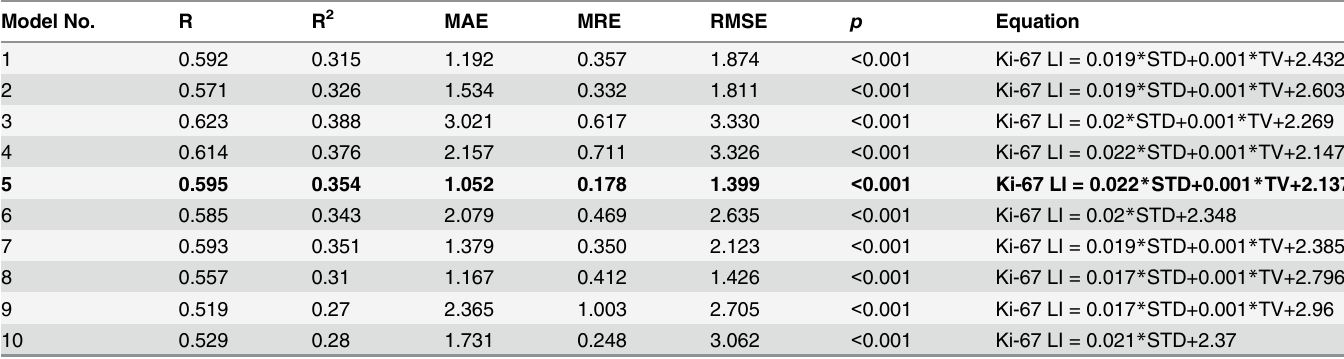
Table 3. 10-fold cross-validation of multi-linear regression model for Ki-67 by CT image parameters of 160 cases. Model